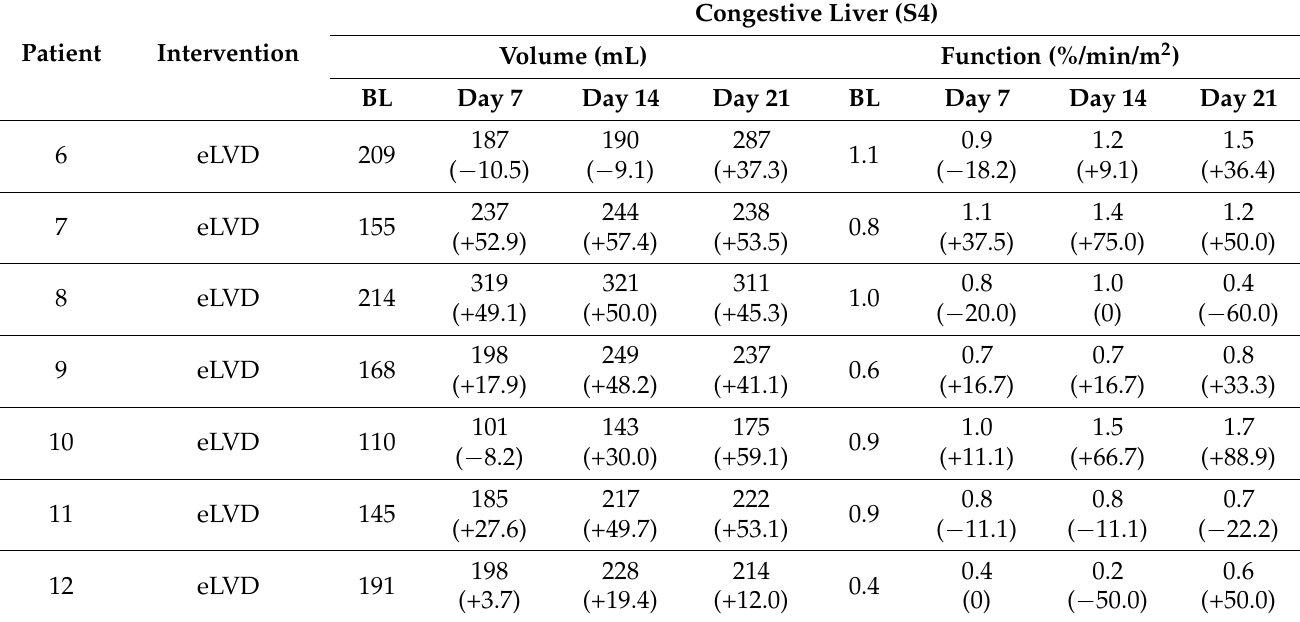
Figure 7. Graphs representing volume intraobserver variability ( a ), volume interobserver variability ( b ), function intraobserver variability ( c ) and function interobserver variability ( d ) with excellent correlation and concordance. Table 4. Volume and function raw data in the congestive liver (S4 after